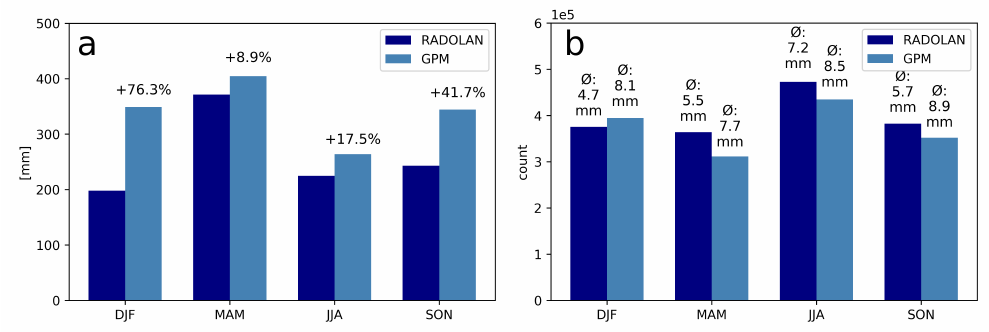
Figure 5. Mean of seasonal precipitation sums ( a ) and seasonal count and mean precipitation of “wet days” ( b ) of the GPM and RADOLAN datasets.